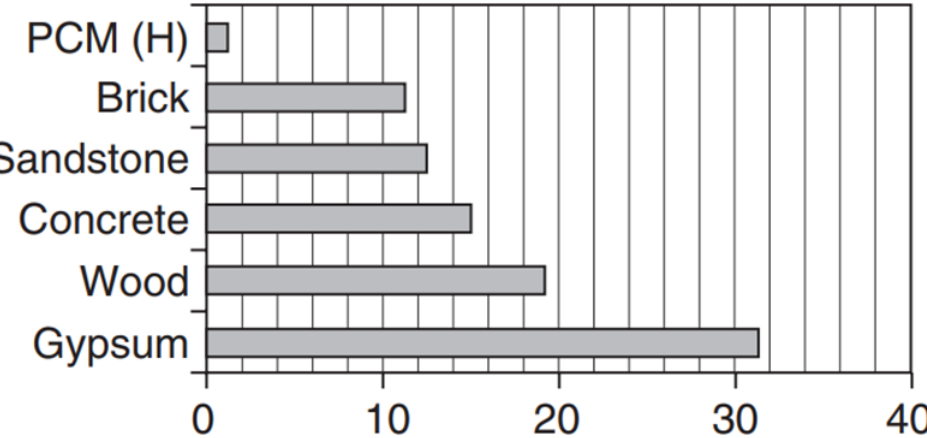
Figure 1. The thickness of PCMs required, compared to conventional thermal masses (e.g., gypsum, wood, concrete, sandstone and brick), for building envelope applications. This figure was redrawn based on [3].